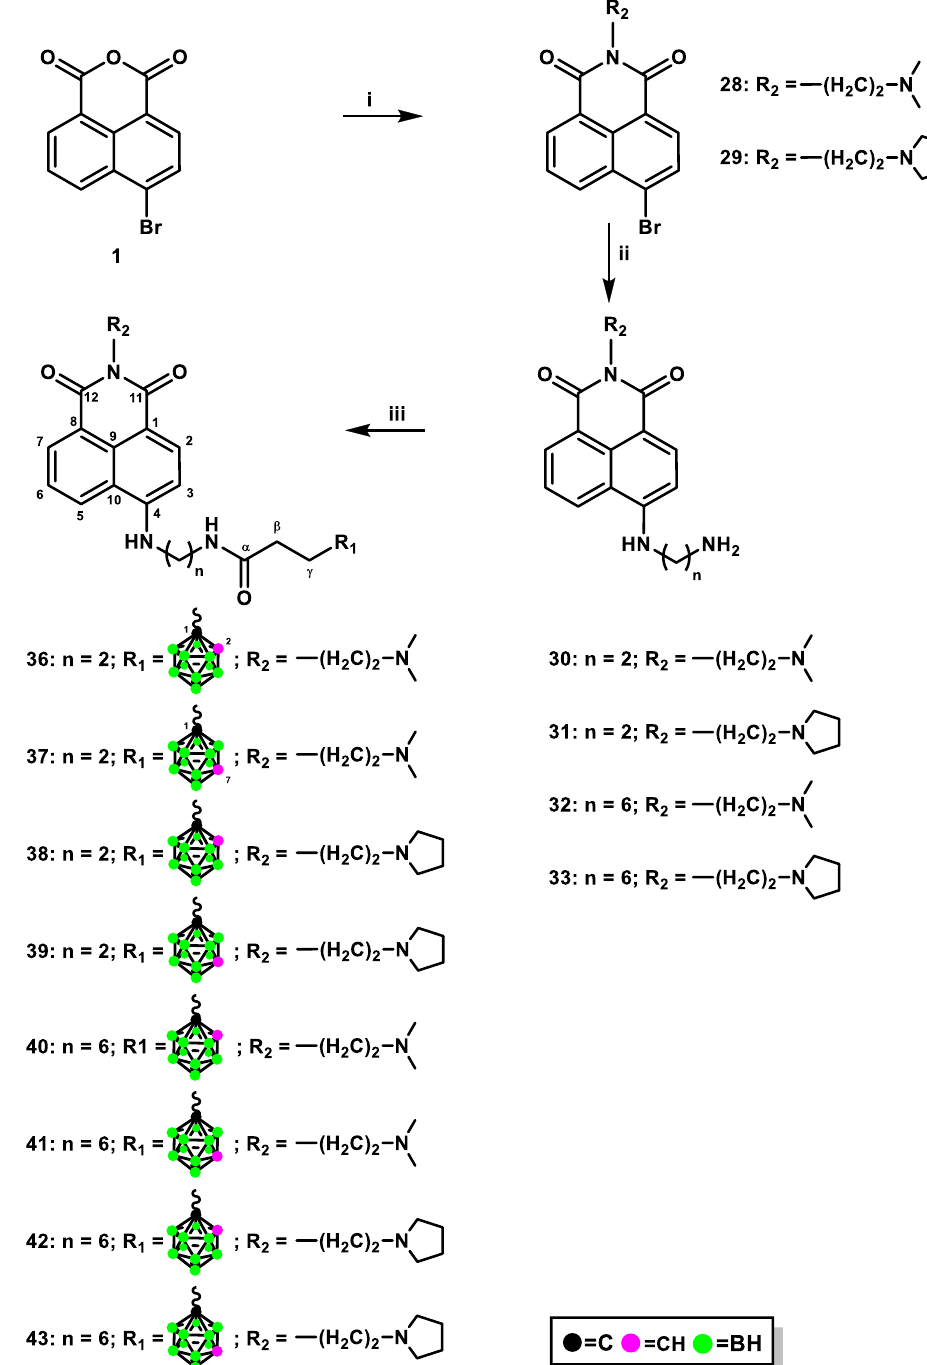
Scheme 4. Modification of 1,8-naphthalimide derivatives with ortho -/ meta -carborane through the formation of an amide bond. ( i ). N , N -dimethylethylenediamine, EtOH, 2 h, 45 °C (for 28 ); N -(2- aminoethyl)pyrrolidine, EtOH, 2 h, 45 °C (for 29 ); ( ii ). ethane-1,2-diamine, 2-methoxyethanol, 7 h, reflux (for 30 and 31 ); hexane-1,6-diamine, 2-methoxyethanol, 7 h, reflux (for 32 and 33 ); ( iii ). 3-(1,2- dicarba- closo -dodecaboran-1-yl)propionic acid N -succinimidyl ester ( 34 ), CH 2 Cl 2 , 5 h, 40 °C (for 36 , 38 , 40 , and 42 ); 3-(1,7-dicarba- closo -dodecaboran-1-yl)propionic acid N -succinimidyl ester ( 35 ), CH 2 Cl 2 , 1.5–5 h, 40 °C (for 37 , 39 , 41 , and 43 ).